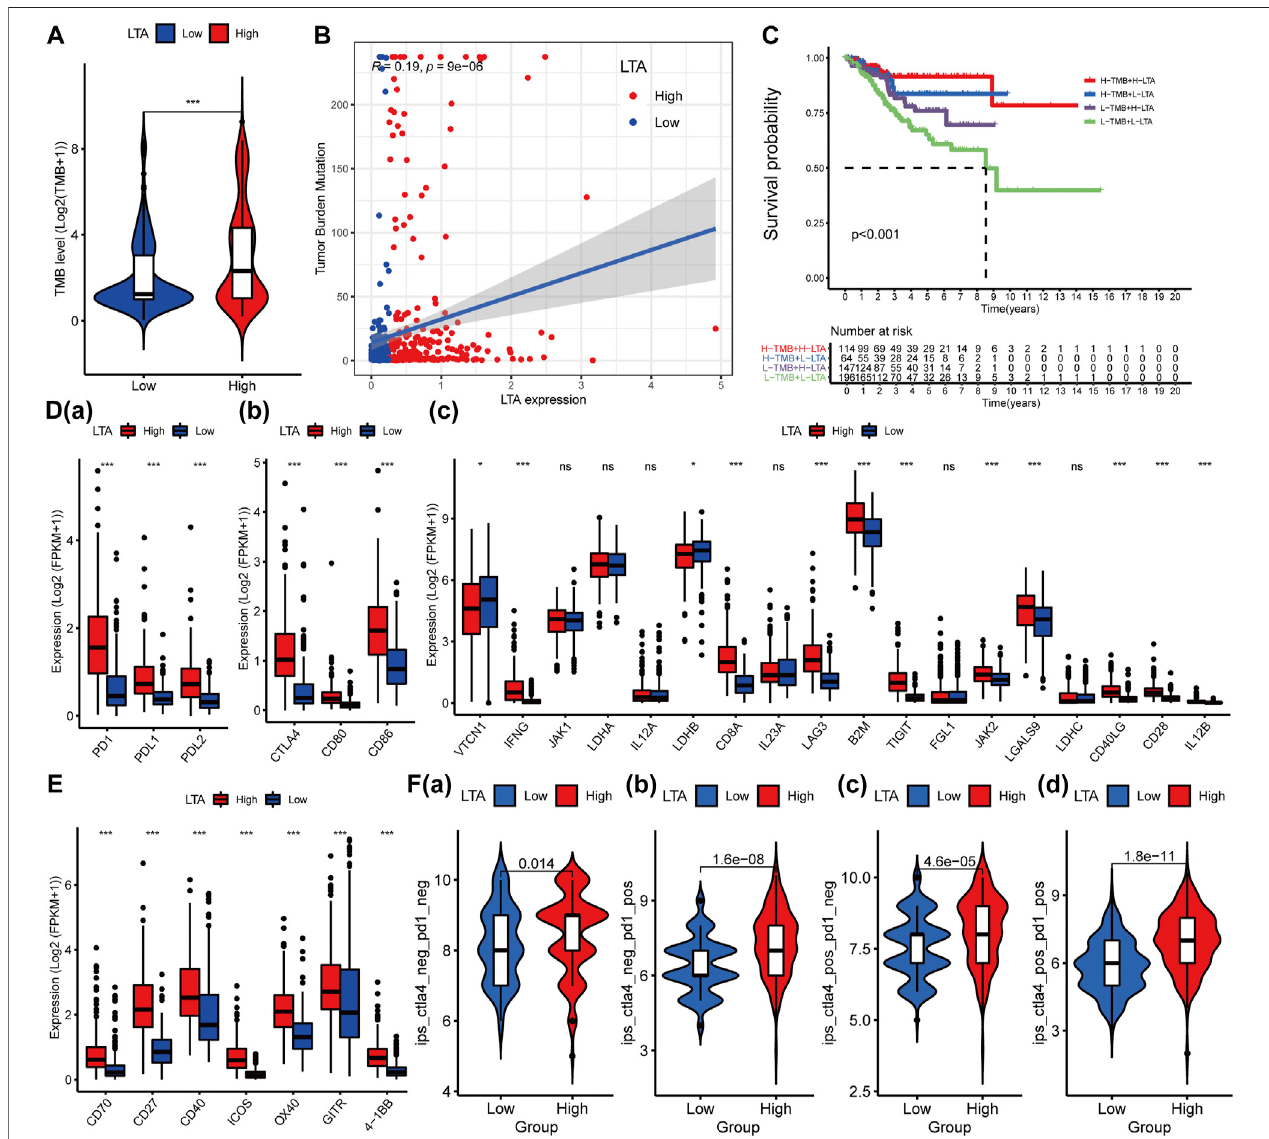
FIGURE5| In fl uenceofLTAonTMBandimmunoregulatorytargets ’ expressioninclinicaltrialsforpatientswithUCEC.ThedifferenceofTMBinhigh-andlow-LTA groups (A) , their correlation (B) , and their impact on the overall survival of the patient (C) . Effect of LTA on immunoregulatory targets ’ expression such as PD1 (D(a)) , CTLA4 (D(b)) ,andothers (D(c)) ,and agonists ofT-cellactivation (E) . (F) Immunotherapyscoreoflow- andhigh-LTA groupsbasedontheTCIAdatabase.The p -values were labeled by asterisks (ns, no signi fi cance, ** p < 0.01, *** p < 0.001).